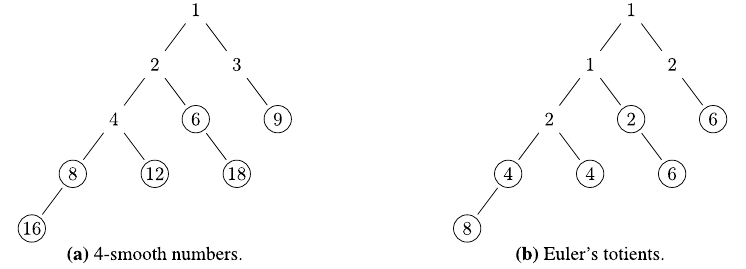
Figure 2. Traversal of the 4-smooth numbers in the interval [5, 20] by Algorithm 3 when n ⌊√ n -smooth numbers is shown in ( a ). Their corresponding totients are shown in ( b ). The numbers for which ⌋ the visitor function is called are circled. The list of prime numbers in this case is P